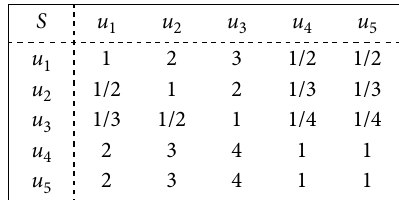
Table 9. Pair-wise comparison matrix of similar units of the causal factors of